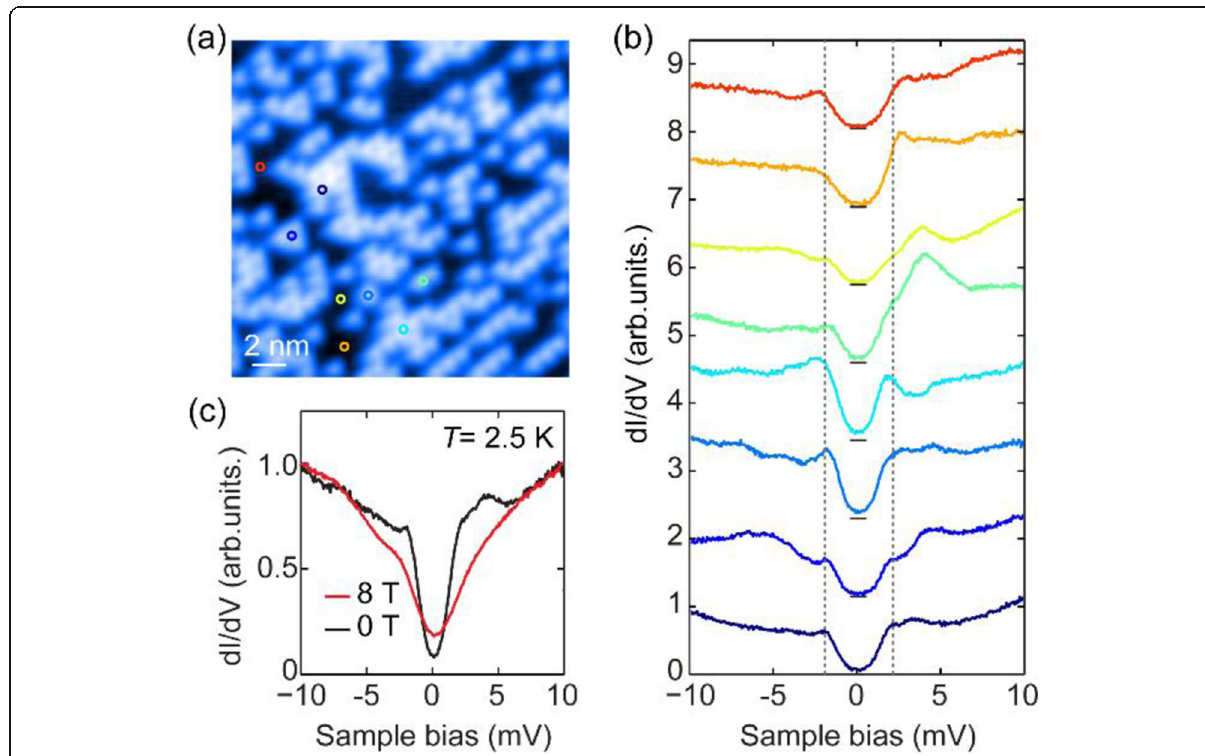
Fig. 16 Superconductivity in 2 ML K 3.36 C 60 . ( a ) STM topography of bilayer K 3.36 C 60 , with excess K dopants randomly distributed. ( b ) d I /d V spectra measured at T =2.5 K, color-coded to match the probe positions (empty circles) in ( a ). ( c ) Spatially averaged d I /d V spectra at B = 0 T (black curve) and B = 8 T (red curve). Taken from ref. [45]